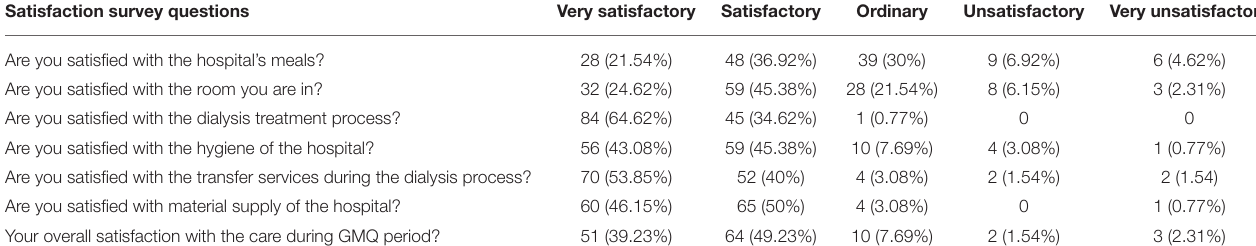
TABLE 2 | Data of patient satisfaction questionnaire.